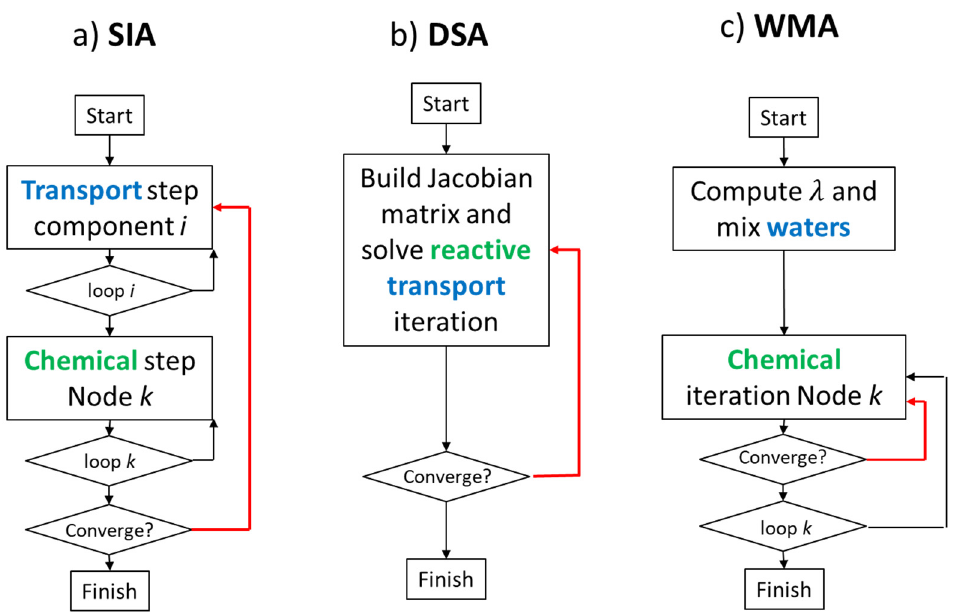
Figure 14. Algorithm of the reactive transport methods: ( a ) Sequential Iteration Approach, ( b ) Direct Substitution Approach and ( c ) Water Mixing Approach.